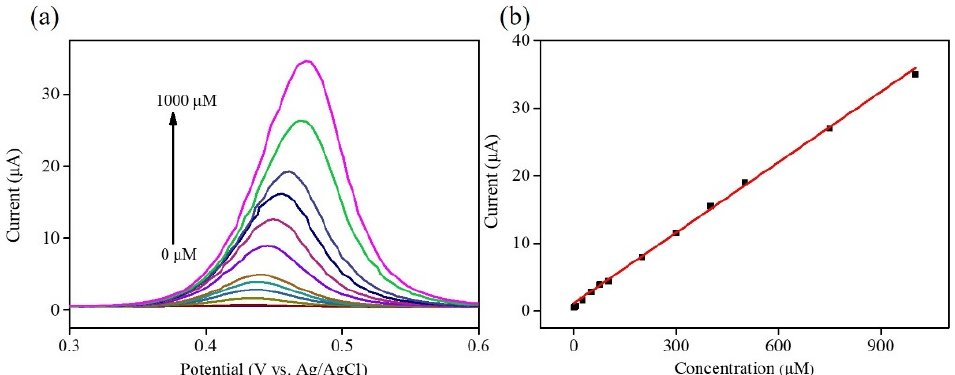
Figure 7. ( a ) DPV curves of Ni–Co–Te/Nafion-modified GCE for acetaminophen in 0.1 M PBS (pH = 7.0) with the successive addition of various acetaminophen concentrations (0~1000 µ M). ( b ) Plot of acetaminophen concentration vs. the anodic peak current. Table 2. Comparison of the performance of electrochemical acetaminophen sensing using transition metal compounds based materials.